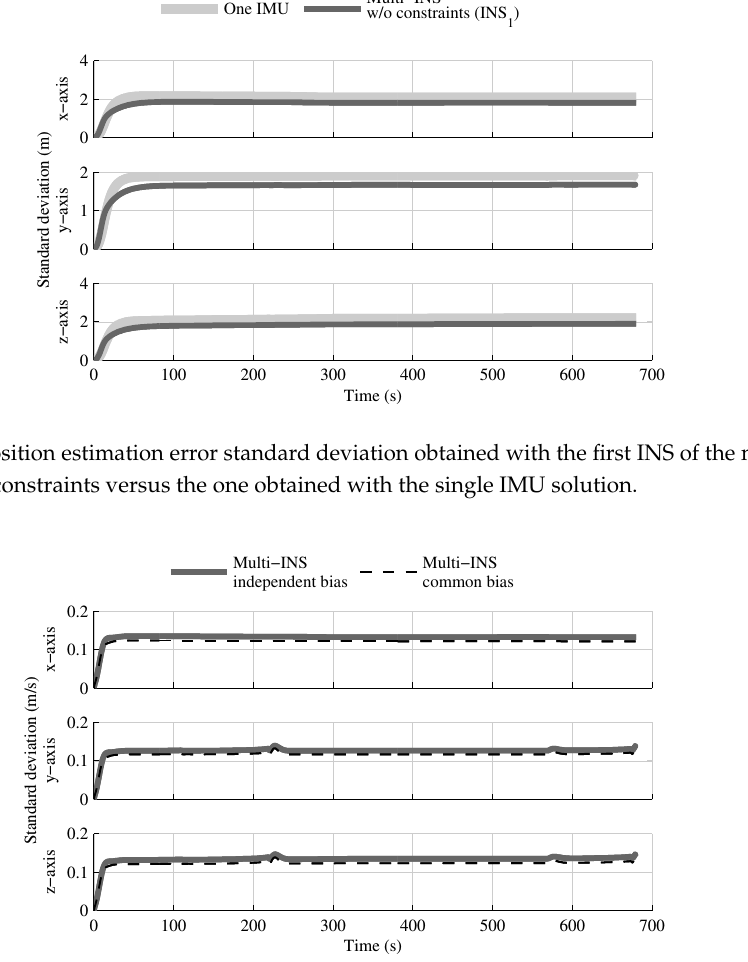
Figure 8. The velocity standard deviation obtained with a common GPS bias estimation versus one GPS bias estimated for each INS in the multi-INS fusion without constraint, when all sensor measurements are present.